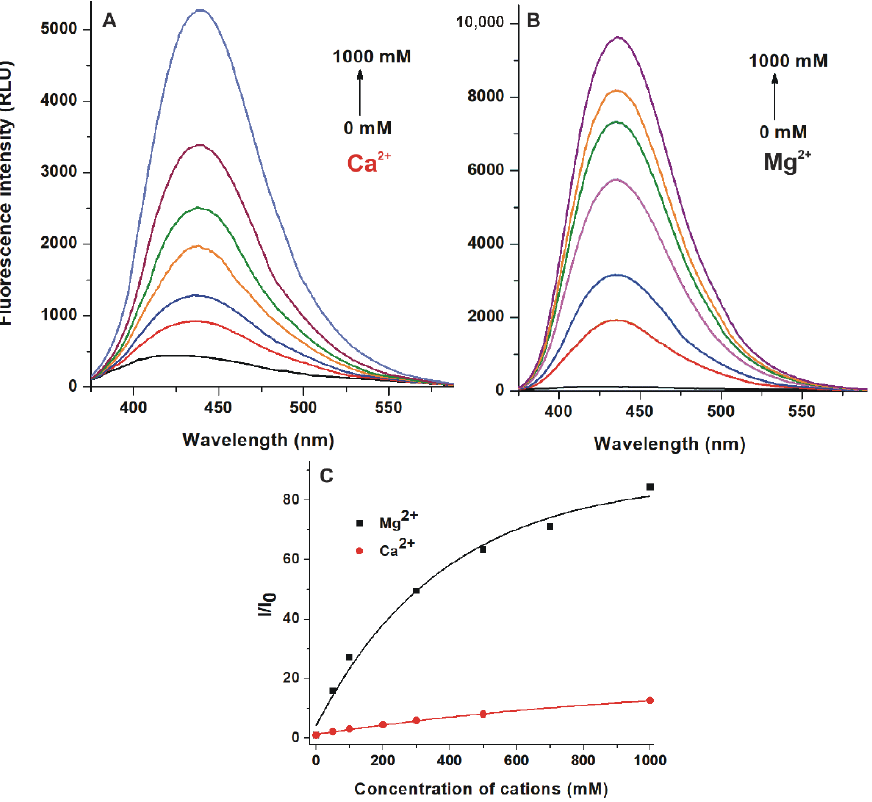
Figure 5. Fluorescence emission spectra of AOH (5 μ M) in the presence of increasing Ca 2+ ( A ; ex and em slits: 10 nm) and Mg 2+ ( B ; ex slit: 5 nm, em slit: 10 nm) concentrations in Tris-HCl buffer (50 mM, pH 7.0). Cation-induced relative increase in the emission signal of AOH ( C ; λ ex = 345 nm, λ em = 440 nm; RLU: relative light unit). Table 1. Binding constants ( K ) of AOH-cation complexes in Tris-HCl buffer (50 mM, pH 7.0).